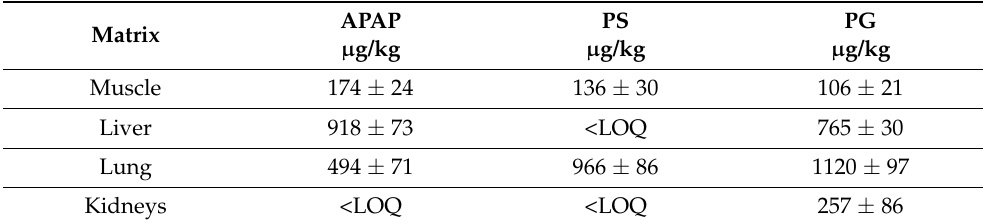
Table 3. Results of muscle, liver, lung, and kidney samples collected during depletion study. Tissues were collected after a single oral administration of acetaminophen at 10 mg/kg in geese. Obtained values are presented as mean value ( n = 8) ± standard